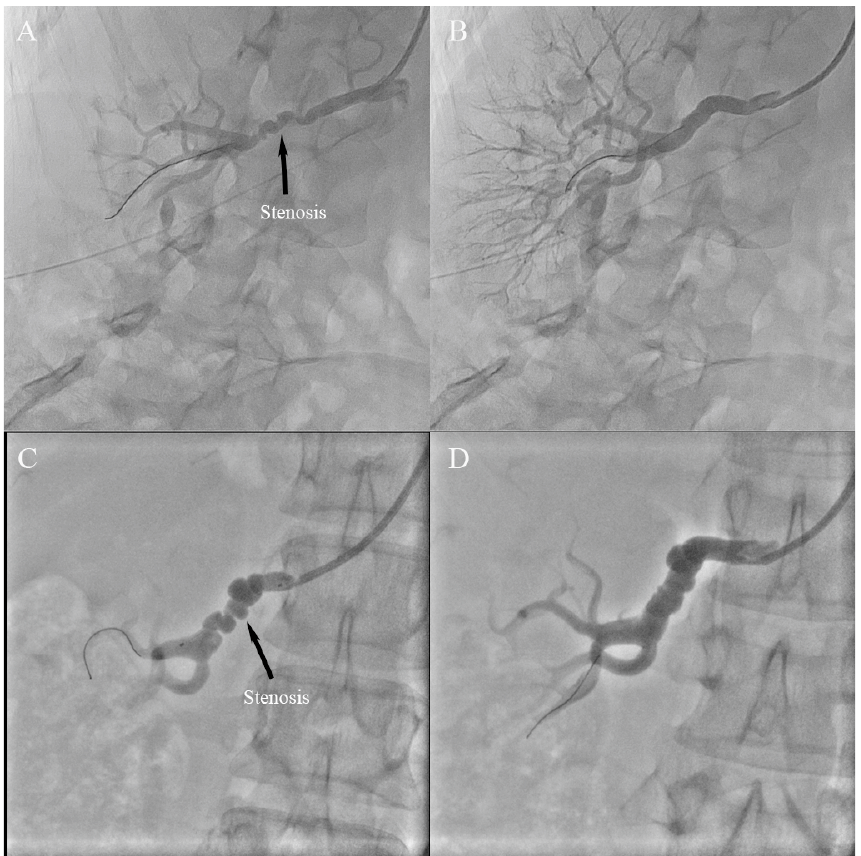
Figure 3. String-of-beads renal artery stenosis in a male patient with fibromuscular dysplasia. ( A ) the “string of beads” appearance of the renal artery and ( B ) post-successful percutaneous transluminal renal angioplasty of the lesion; ( C ) catheter-based angiography shows the recurrence of stenosis in the same patient after 8 years and ( D ) showing the result of successful reintervention.